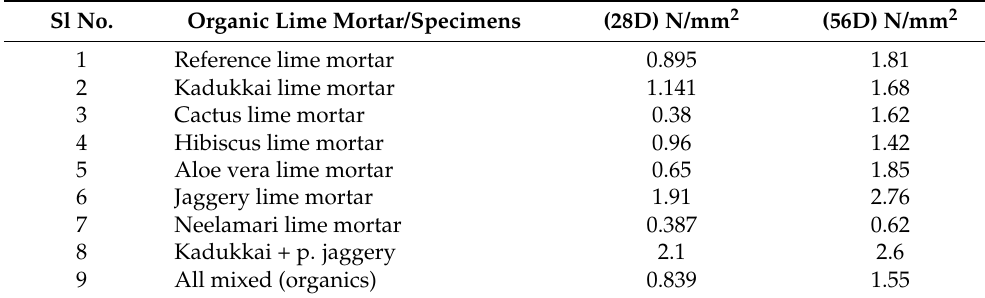
Table 3. Compressive strength of the organic lime mortar. Sl